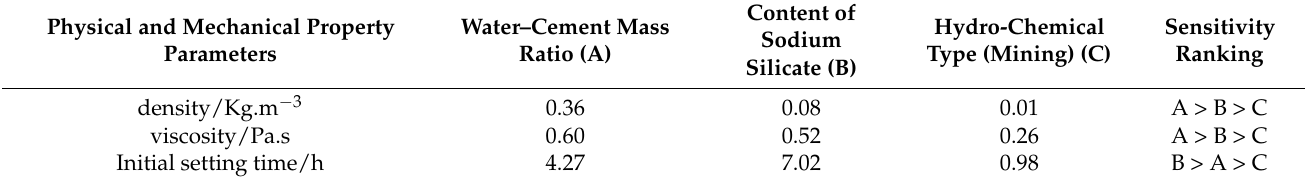
Table 6. Range of grout properties under various influence factors and their sensitivity ranking to those